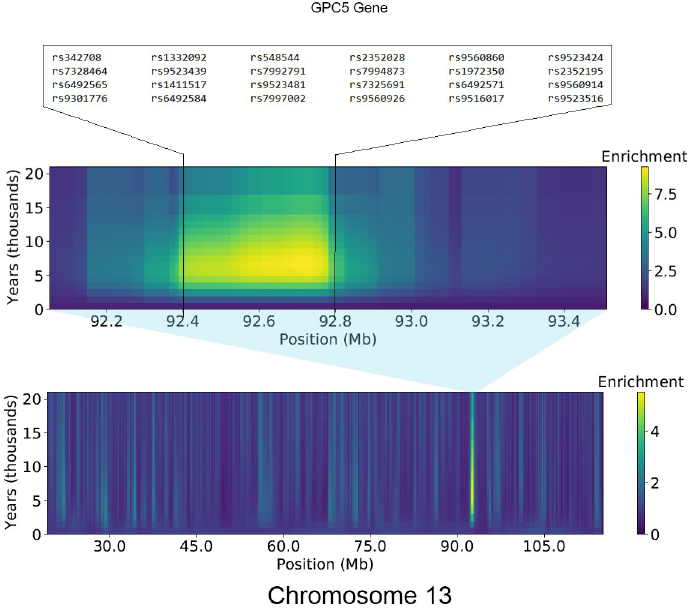
Fig 3. Ascertained Sequentially Markovian Coalescent (ASMC) results for chromosome 13. Showing with a greater resolution the region including the gene GPC5 where the highest enrichment in recent coalescence events is concentrated on this